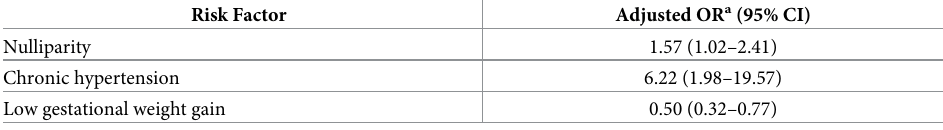
Table 3. Results from the multivariate logistic regression